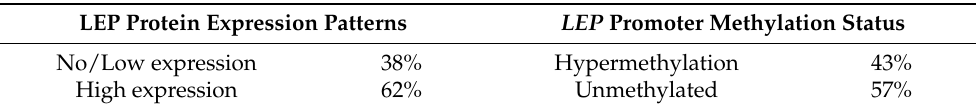
Table 3. Concordance between LEP protein expression profiles and their promoter methylation patterns in Saudi OC patients.